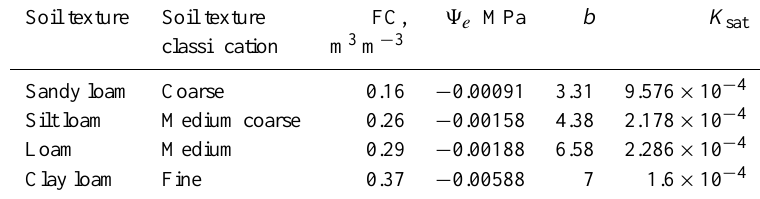
Table 3. Water holding characteristics of four soil texture classes, after Campbell (1985) and Tuzet et al. (2003). Soil texture Soil